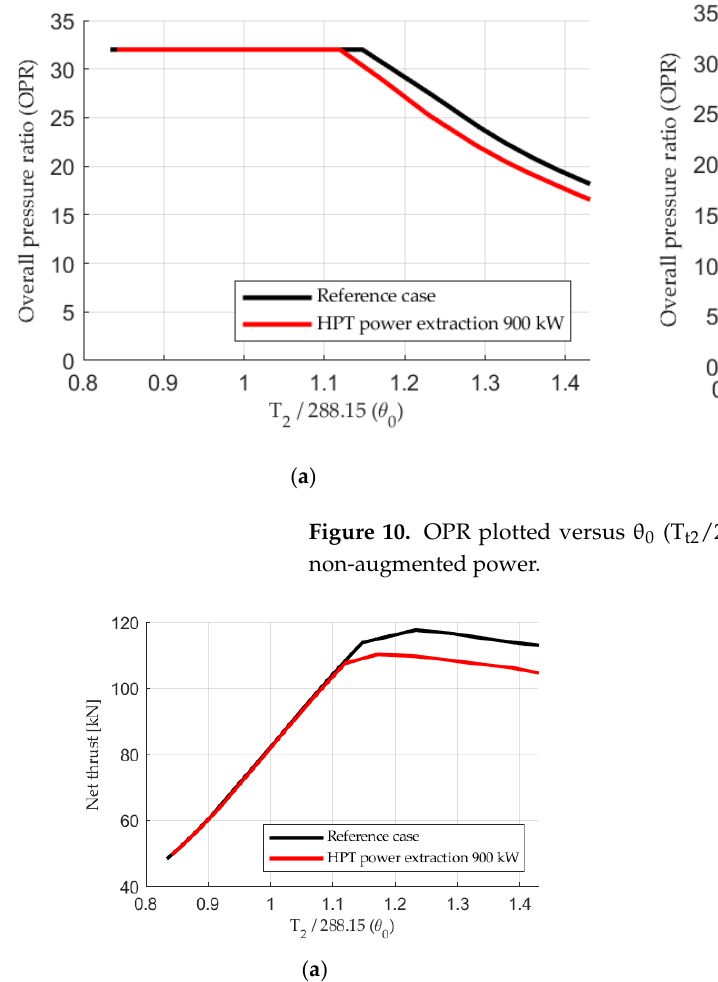
Figure 11. Net thrust plotted versus θ 0 (T t2 /288.15); ( a ) Maximum augmented power; ( b ) Maximum non-augmented power.